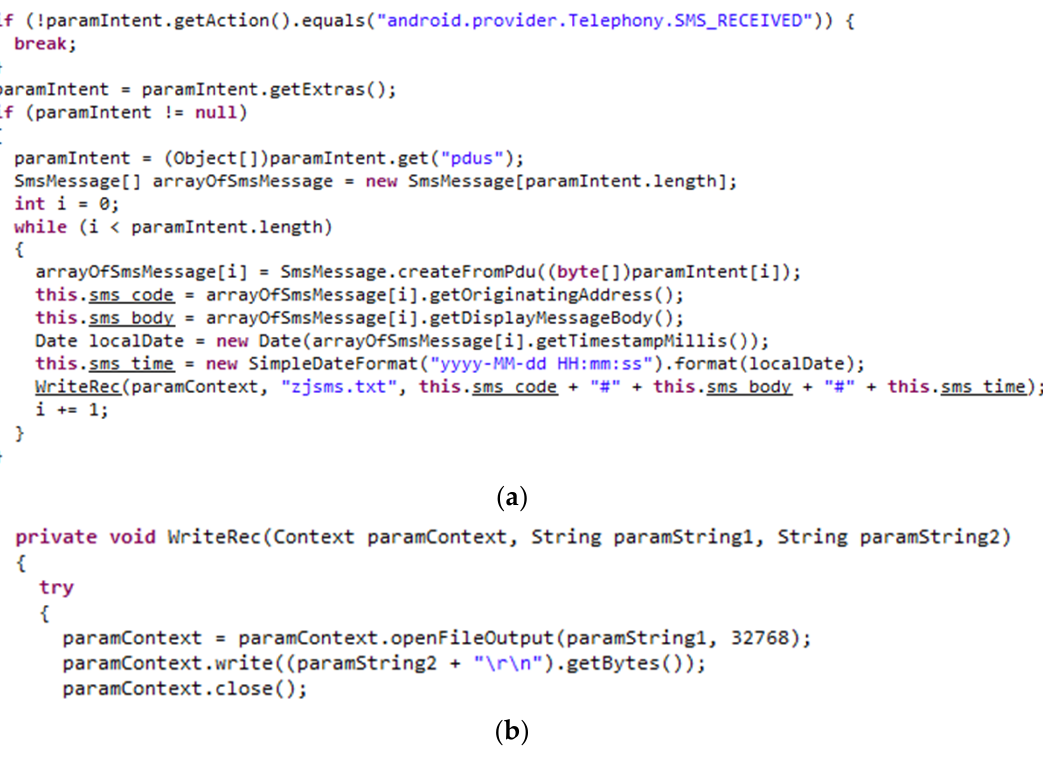
Figure 8. Implementation code for obtaining sensitive information contained in incoming SMS in the GoldDream sample: ( a ) handling of incoming SMS; ( b ) writing to a file in the WriteRec method. There are three key steps in the code.